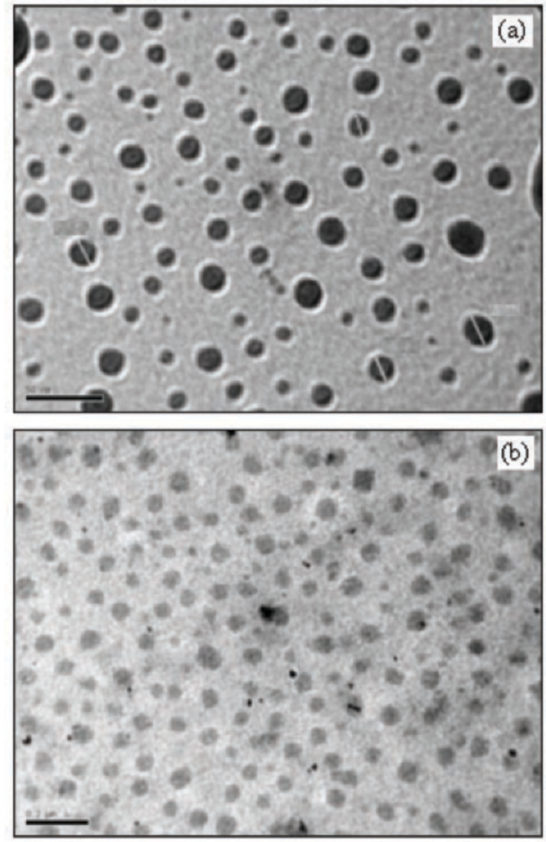
Figure 8. TEM images of alumina doped SnO (a) using sol-gel and (b) direct precipitation methods. Scale bar (a) 50 nm and (b) 200